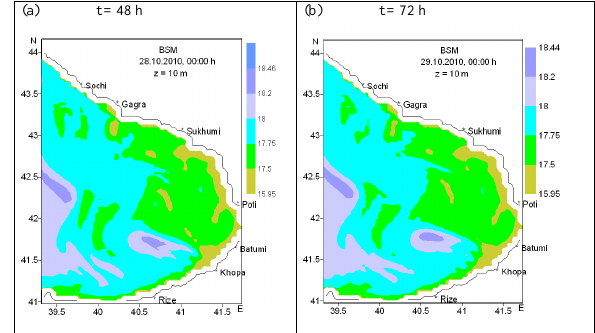
Fig. 19. The salinity fields (psu) on depth of 10 m predicted by BSM of MHI at 48 h (a) and 72 h (b) (the forecasting period is 26.10.2010, 00:00 h – 29.10.2010, 00:00 h.).